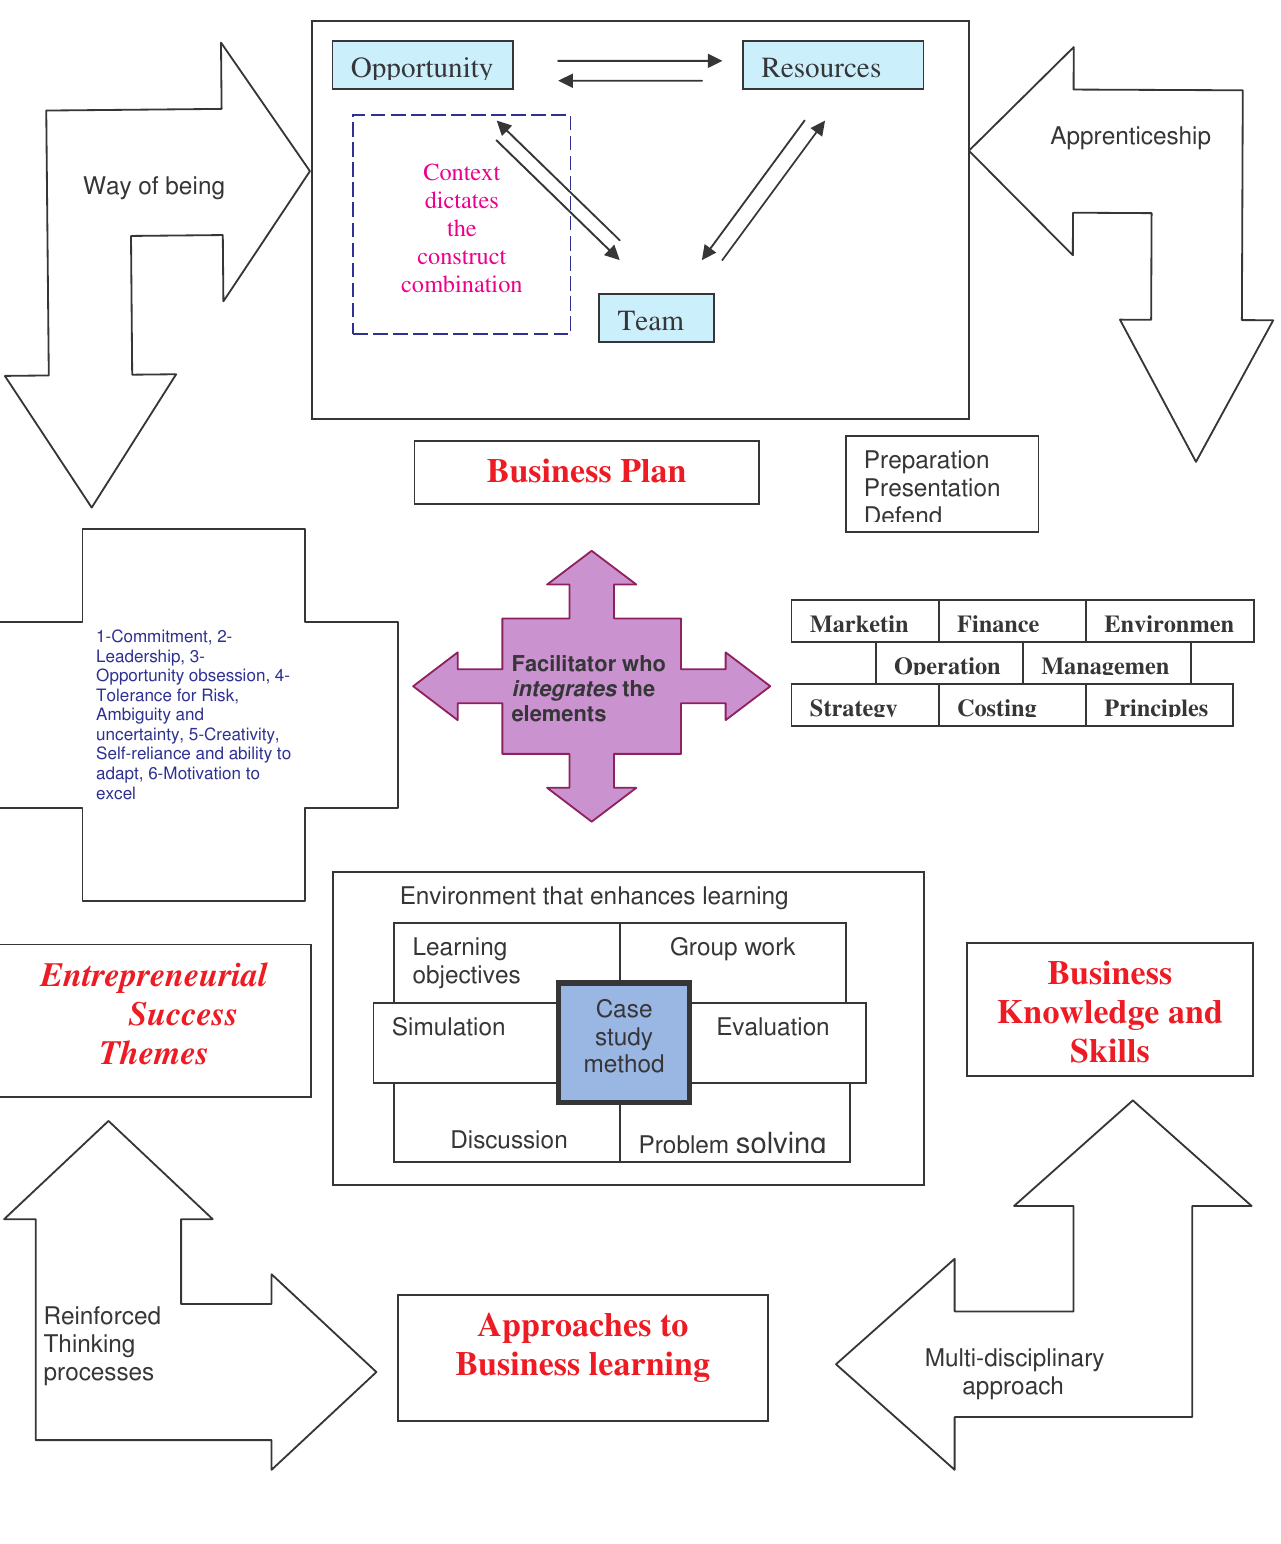
Figure 1: Entrepreneurial learning model and constructs (Pretorius,